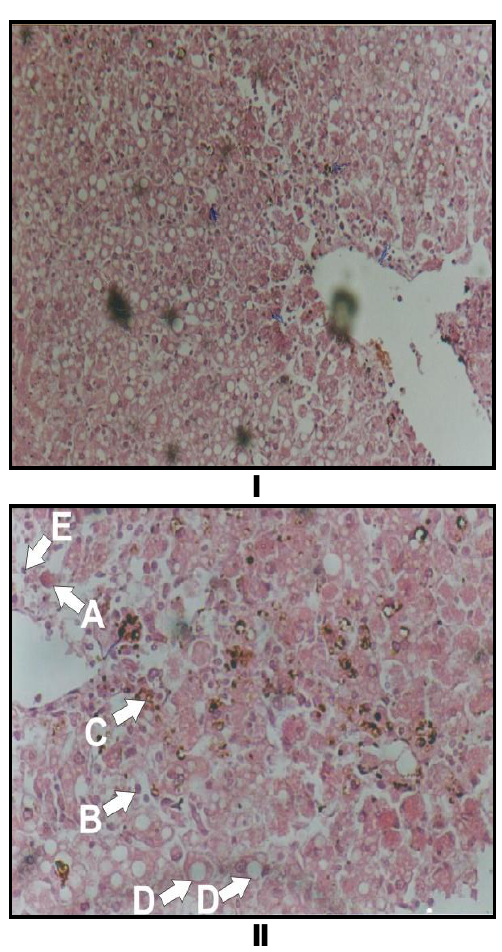
Figure (2): Sections showing morphological alteration of liver from CCl -treated rats 4 - A : Necrotic damage. - B : Ballooning degeneration. - C : Cholestasis. - D : Steatosis .- E : Inflammatory cell infiltration. Magnification: I (10*10), II (10*20); staining: Haematoxylline and Eosin.